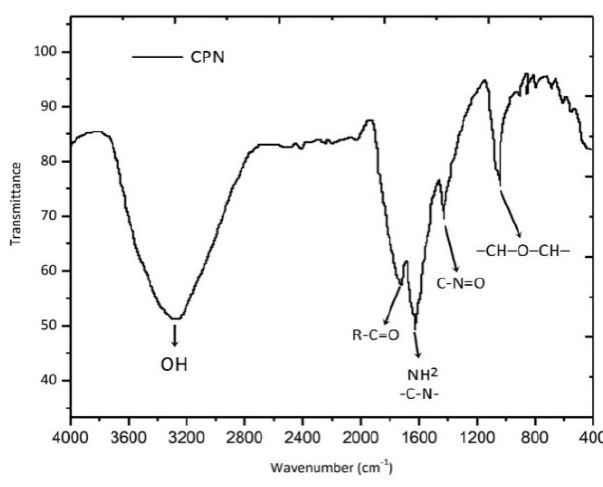
Figure 4. FTIR spectra of CPN.